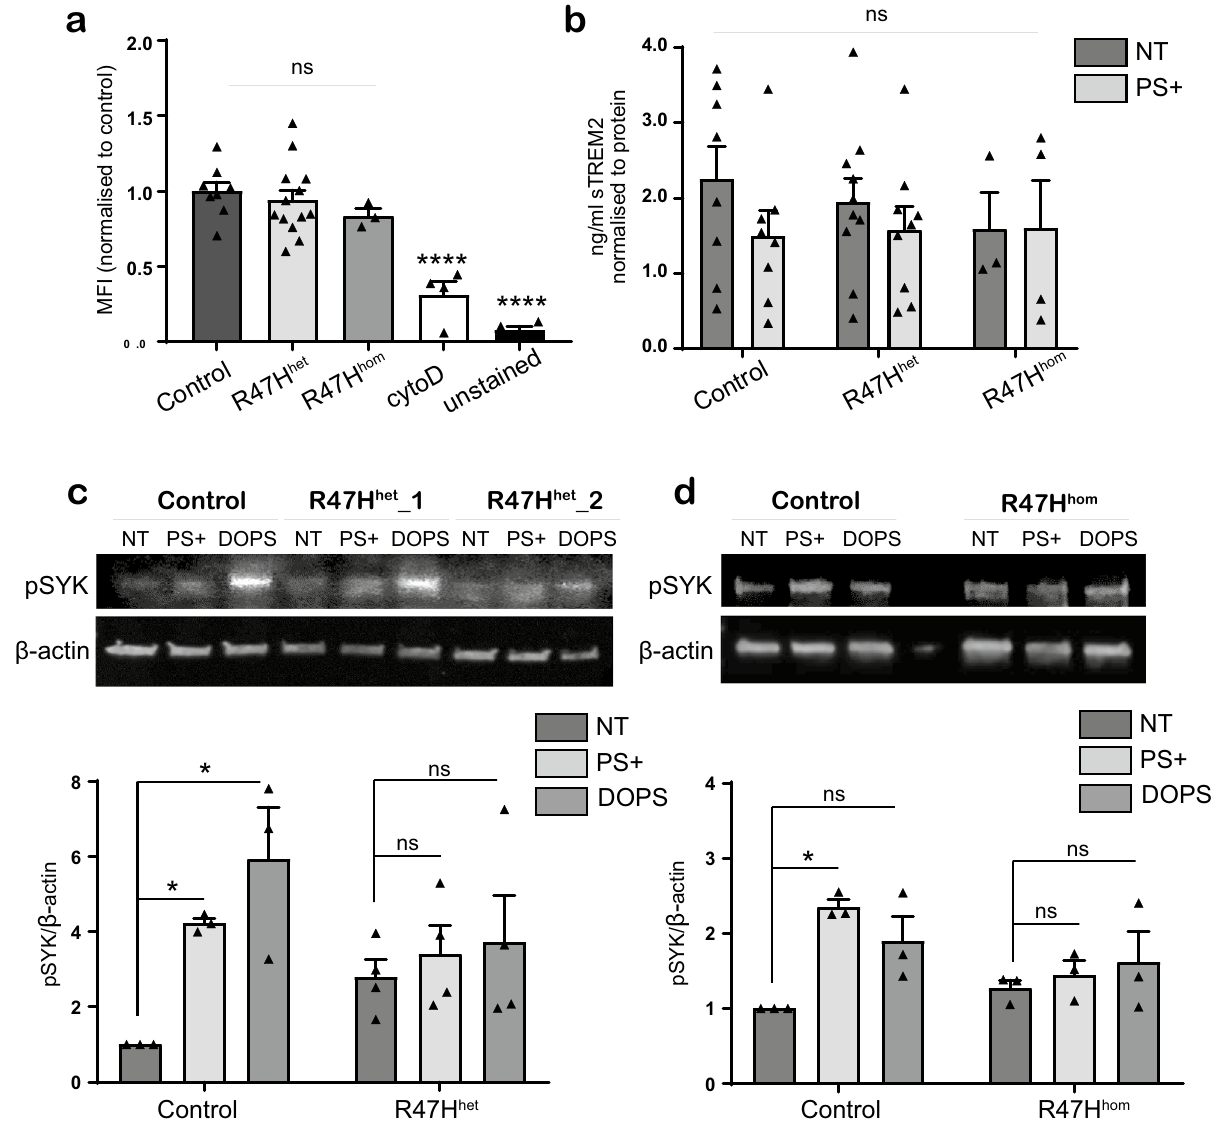
Figure 2. ( a ) Flow cytometry of phagocytosis of DiI-labelled heat-shocked SH-SY5Y cells following 2 h incubation with iPS-Mg in control, TREM2 R47H het and R47H hom lines, with cytochalasin D and unstained control; data are mean ± SEM, n = 3–14 cell lines from 4 individual experiments, **** P < 0.0001 (one-way ANOVA with Tukey’s correction), ns = non-significant. ( b ) ELISA to measure shed TREM2 in supernatant of iPS-Mg from control, TREM2 R47H het and R47H hom lines treated with PS+ SH-SY5Y cells; data are mean ± SEM, n = 3–10 cell lines from 4 individual experiments, ns, no-significant (two-way ANOVA). ( c ) Top, western blot analysis of pSYK signalling in iPS-Mg following 5 min stimulation with PS+ SH-SH5Y cells and DOPS liposomes in control and TREM2 R47H het lines. Bottom, quantification of pSYK protein normalised to beta- actin; data show mean ± SEM, n = 3–4 cell lines from 3 individual experiments, * P < 0.05 (two-way ANOVA with Tukey’s correction). ( d ) Top, western blot analysis of pSYK signalling in iPS-Mg following 5 min stimulation with PS+ SH-SH5Y cells and DOPS liposomes in control and TREM2 R47H hom lines. Bottom, quantification of pSYK protein normalised to beta-actin; data are mean ± SEM, n = 3 cell lines from 3 individual experiments, * P < 0.05 (two-way ANOVA with Tukey’s correction), ns, non-significant. Full length blots are presented in Supplementary Fig.